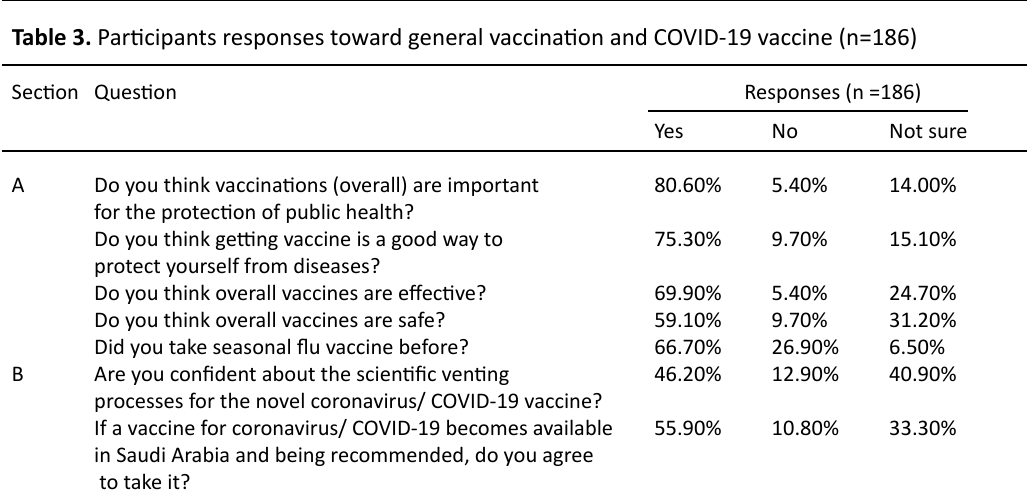
Table 3. Participants responses toward general vaccination and COVID-19 vaccine (n=186) Section